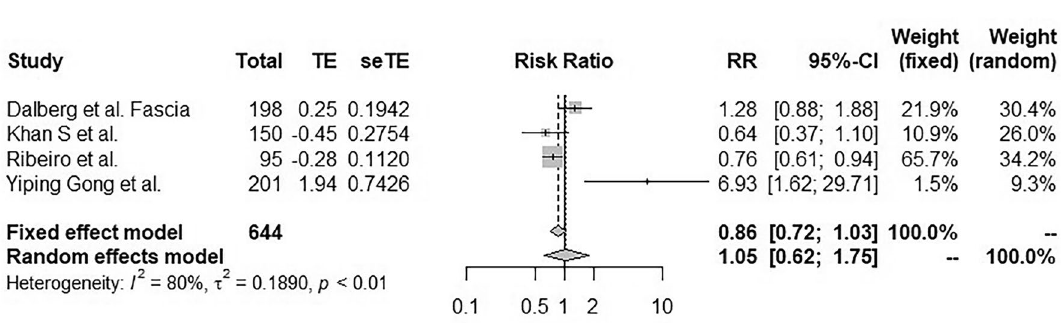
Figure 3. Forest plot for seroma incidence following application of a medical treatment designed to preventing lymphocele after mastectomy with axillary lymphadenectomy. Risk ratios are shown with 95% confidence intervals.